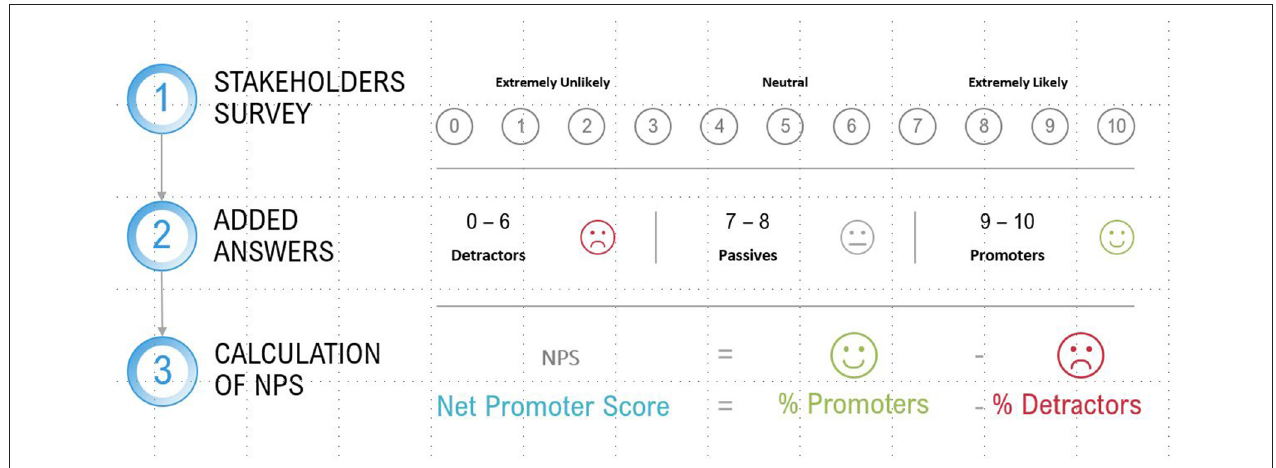
FIGURE 7 | Representation of the net promoter score (NPS). Source: own compilation.